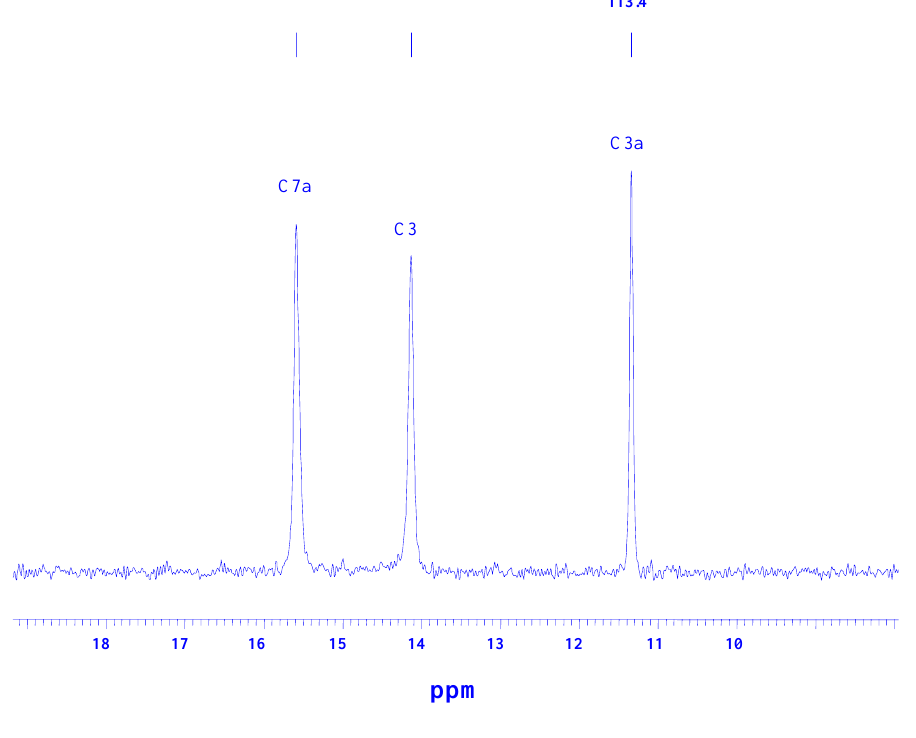
Figure 2 . 13 C-NMR spectrum (aromatic region) of compound 4 in DMSO-d